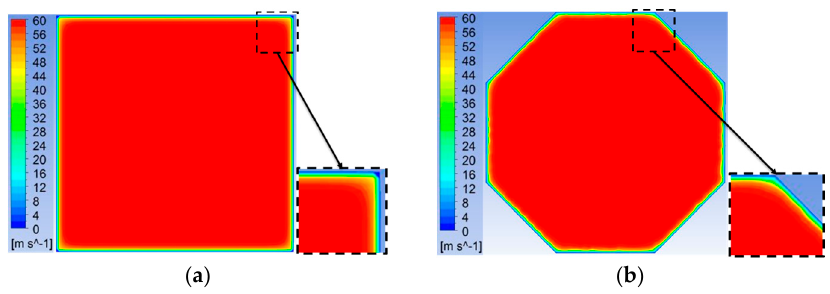
Figure 11. Axial velocity contours at contraction exits (CT #1), ( a ) square cross-sectional shape; ( b ) octagonal cross-sectional shape.